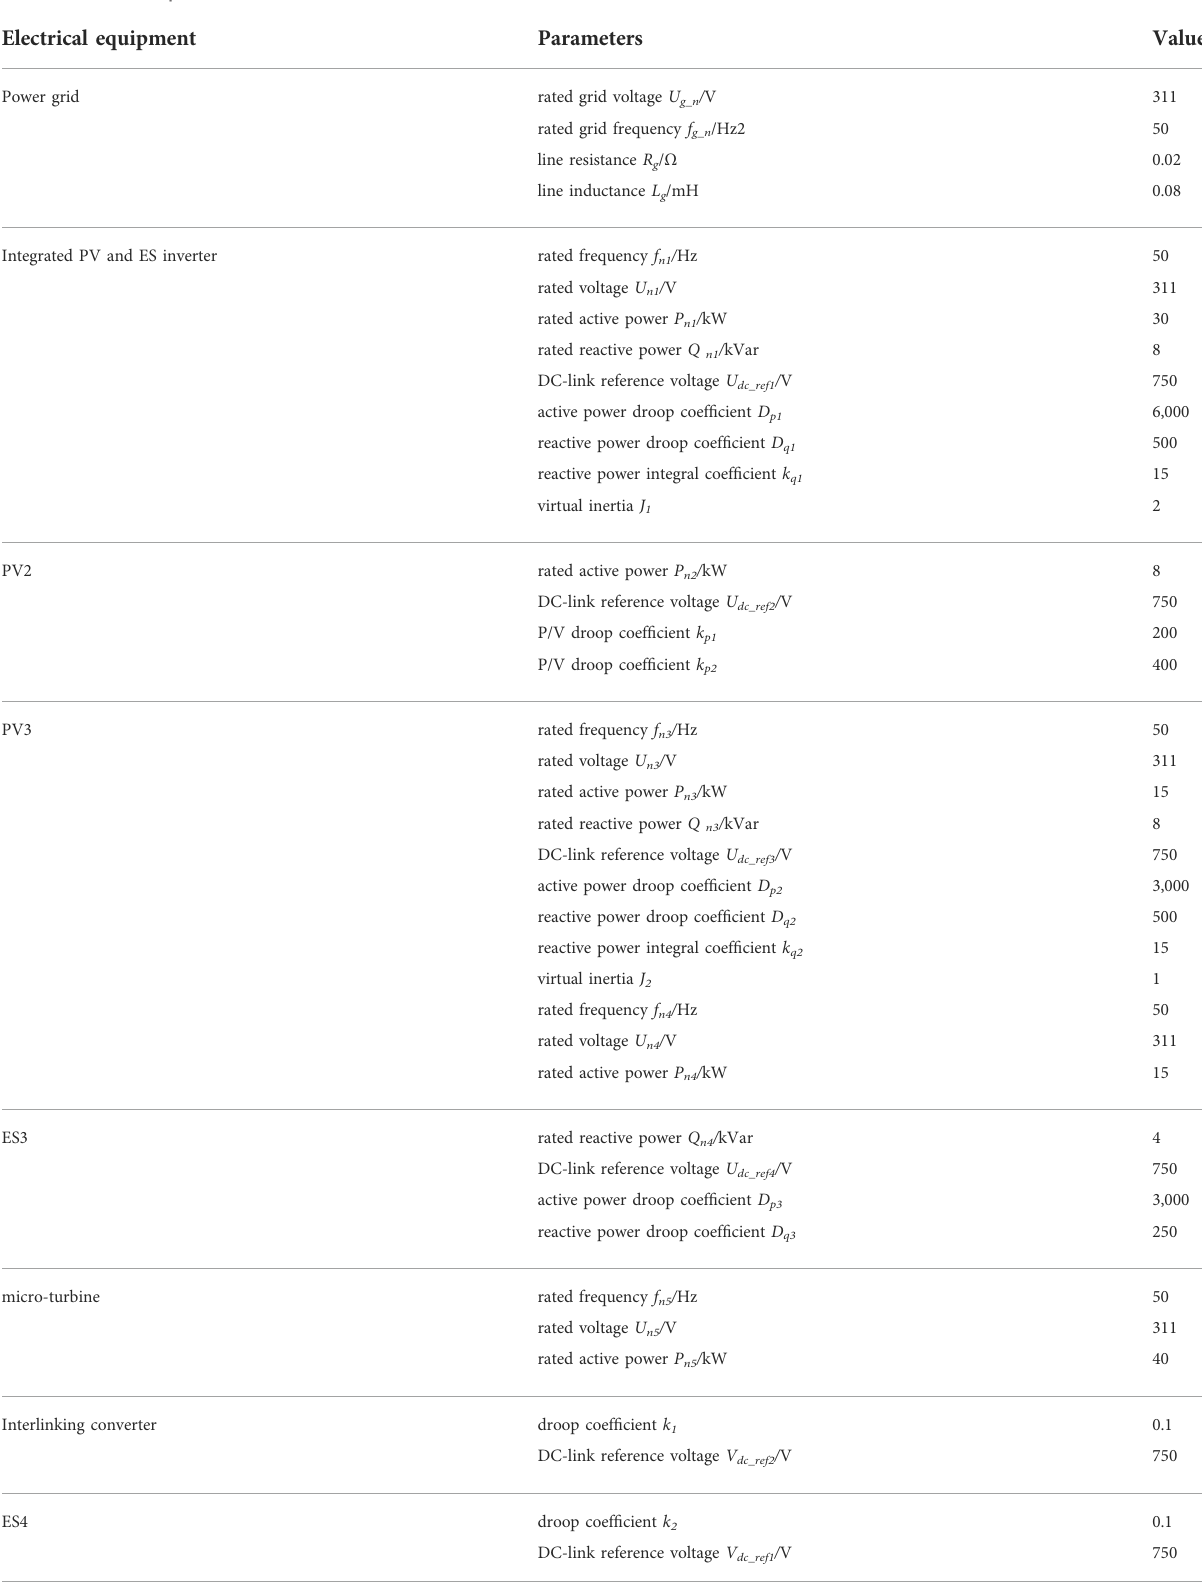
TABLE 2 Simulation